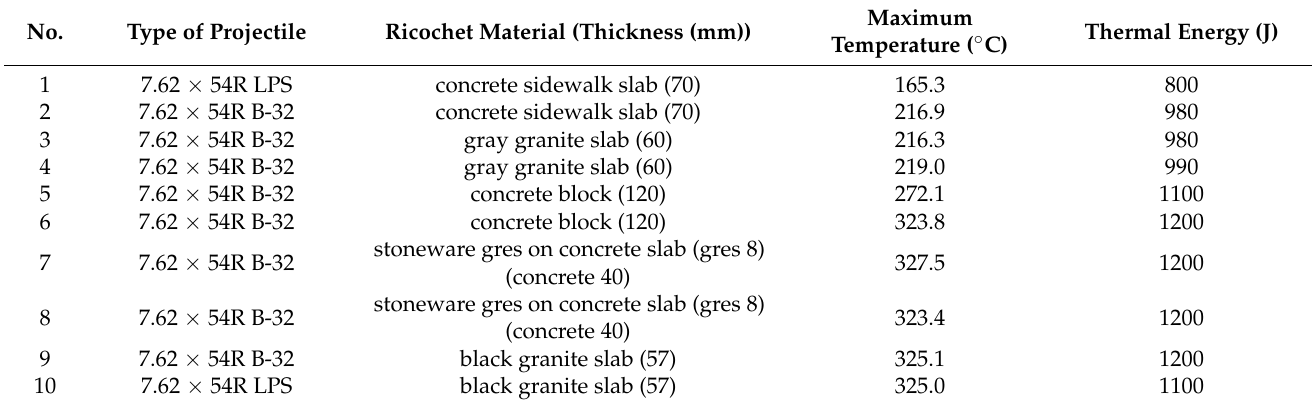
Table 3. Thermal energies during the ricochetting of projectiles on the surface of non-metallic